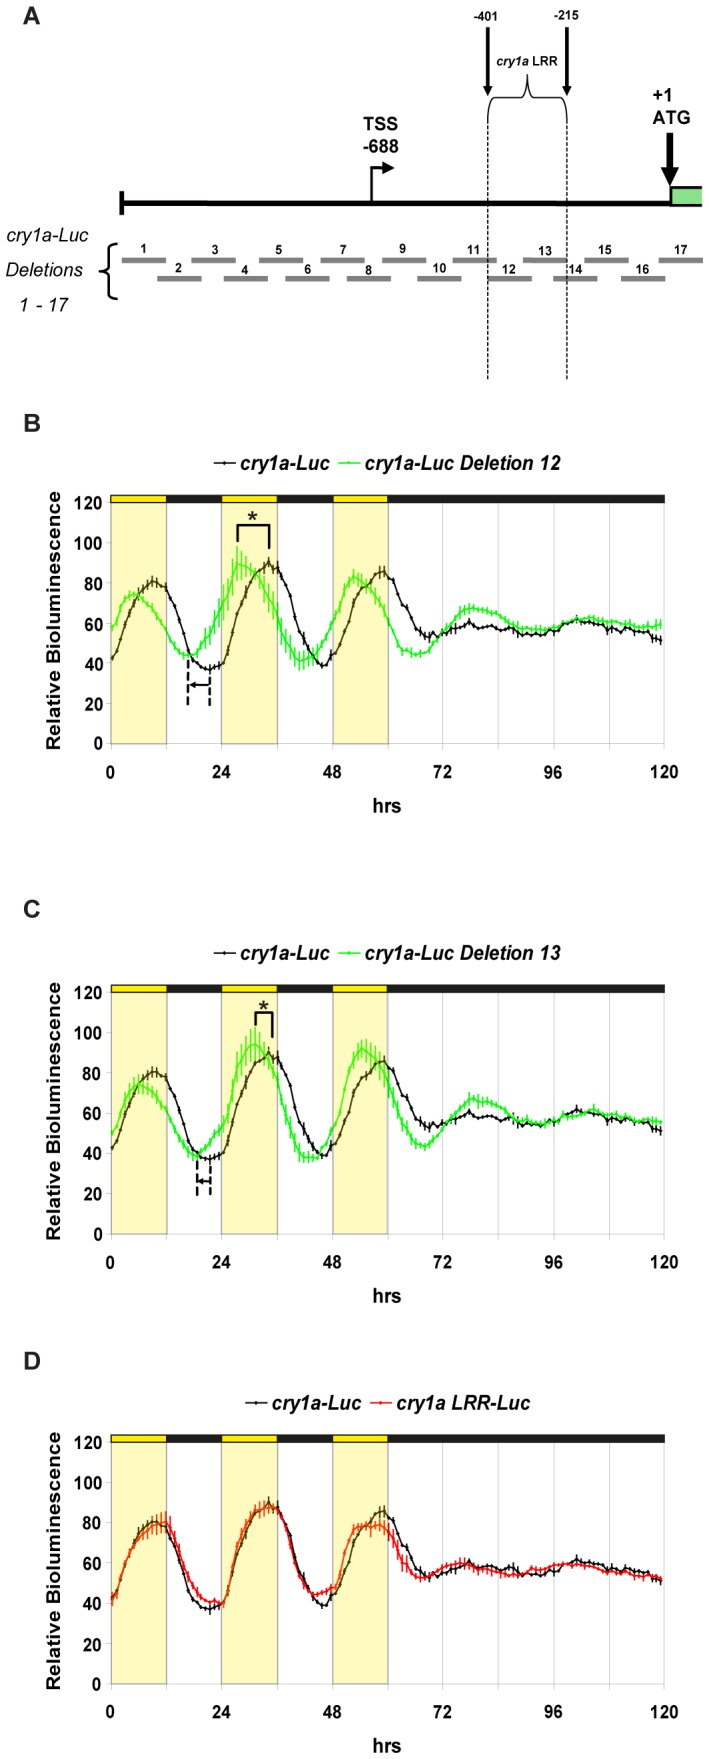
Identification of the light-responsive region within the cry1a promoter.(A) Schematic representation of cry1a-Luc and deletion constructs 1 to 17 (grey bars) (see also Table S5). The 186 bp cry1a light responsive region (cry1a LRR) is indicated by dotted lines and black arrows (region between −401 bp and −215 bp). (B–C) Representative real time bioluminescence assays from PAC-2 cells transfected with cry1a-Luc (black trace) and cry1a-Luc Deletion 12 or cry1a-Luc Deletion 13 (green traces) (Figure 3B and C). In both cry1a-Luc Deletions 12 and 13, the phase of rhythmic expression is significantly shifted (for both p<0.0001, t-test). In deletions 12 and 13, the increase in luciferase activity that anticipates the onset of the light phase is indicated by a horizontal black arrow. (D) Representative real time bioluminescence assay from PAC-2 cells transfected with cry1a-Luc (black trace) and cry1a LRR-Luc (red trace). In each panel relative bioluminescence is plotted on the y-axis and time (hrs) on the x-axis. Each time-point represents the mean of at least four independently transfected wells +/− SD from a single experiment. Each experiment was performed a minimum of three times. Yellow and black bars above each panel represent the light and dark periods, respectively. Statistically significant differences are indicated by an asterisk (*) and are reported in Table S3.